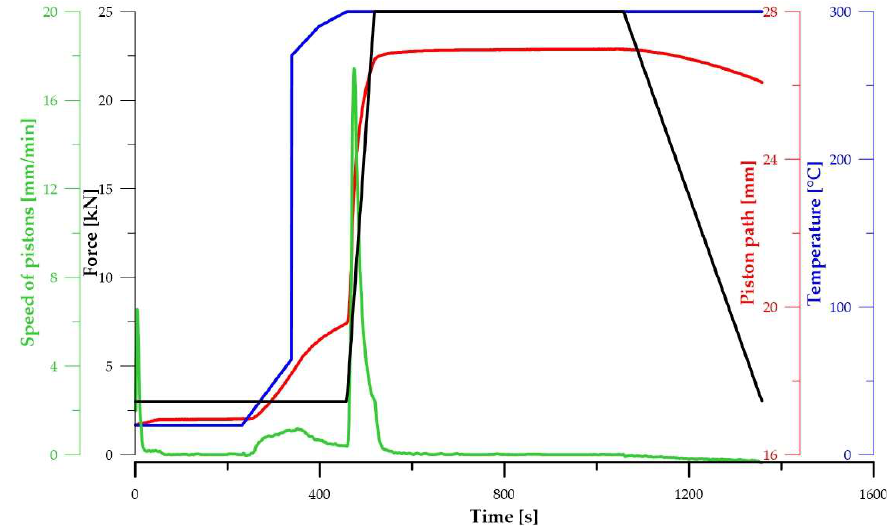
Figure 3. Time profiles of the SPS process